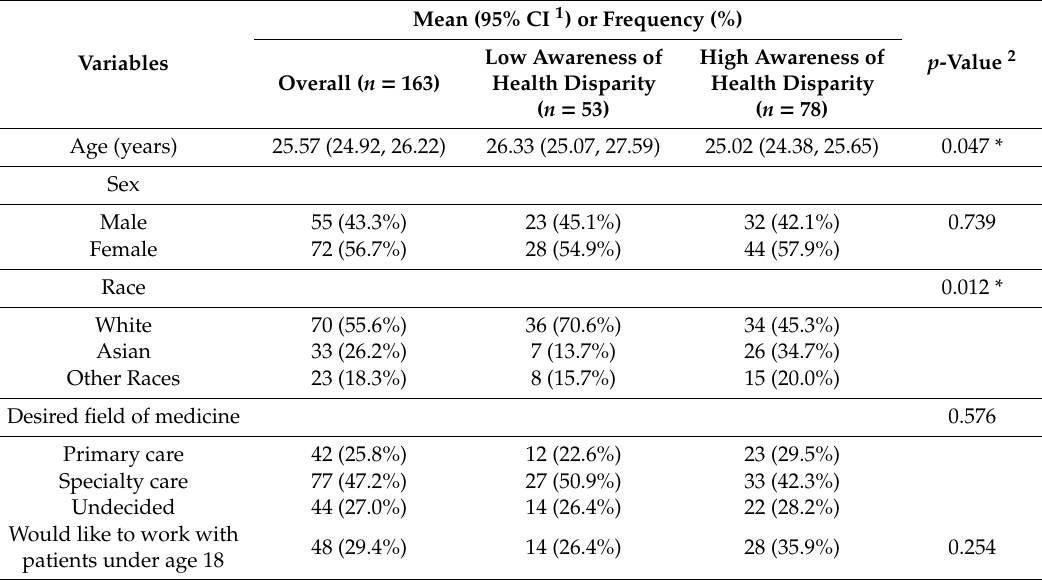
Table 1. Participants’ characteristics by their perception about health